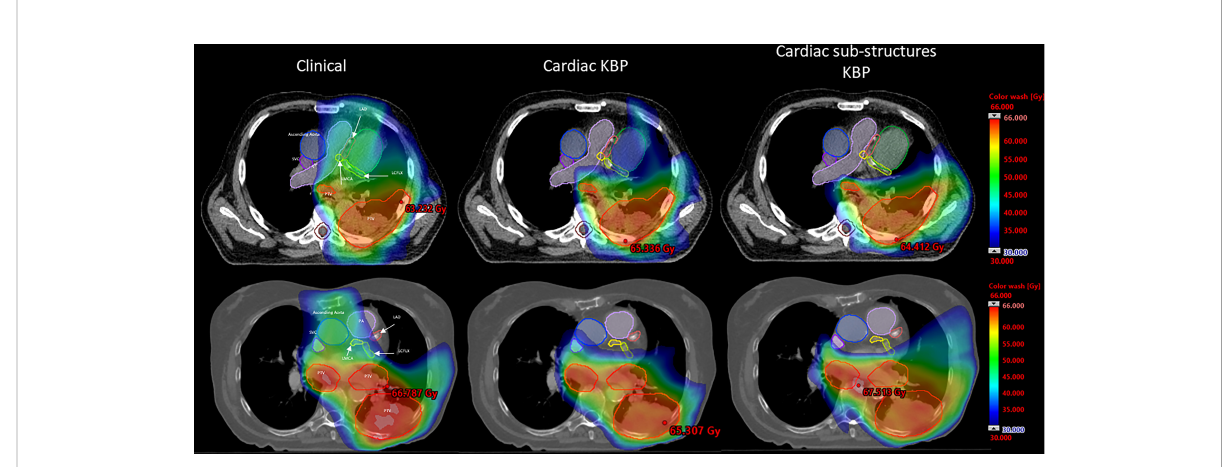
FIGURE 1 Dose distribution comparison between CS-KBP, C-KBP, and manually optimized plans for two sample cases from the validation